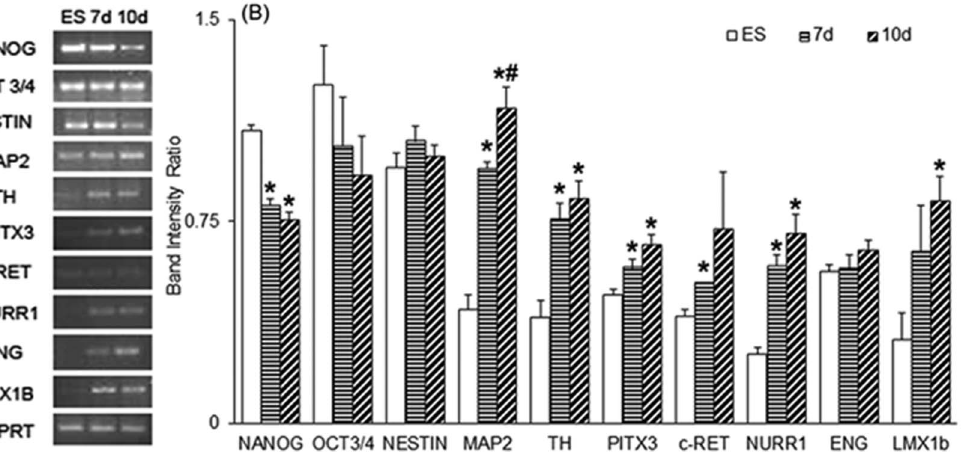
Figure 1. Changes in mRNA expression levels in cells following differentiation. Undifferentiated and differentiated embryonic stem cells (ES), and 7 days and 10 days differentiated (7 d; 10 d) cells were analysed for the mRNA expression of stem cells (NANOG; OCT3/4), neuronal (NESTIN; MAP2) and dopaminergic markers (TH; Pitx3; c-RET; NURR1; LMX1B; ENG). (A) Equal amount of cDNA was amplified for each gene and representative image of agarose gel bands obtained following electrophoresis. (B) Band intensities as normalised by hypoxanthine-guanine phosphoribosyl transferase (HGPRT; as housekeeping gene), showing relative gene expression. Results are Mean 6 S.E.M, n=3–4. * p # 0.05 vs. ES group, # p # 0.05 vs. 7 d group; Student’s t-test.